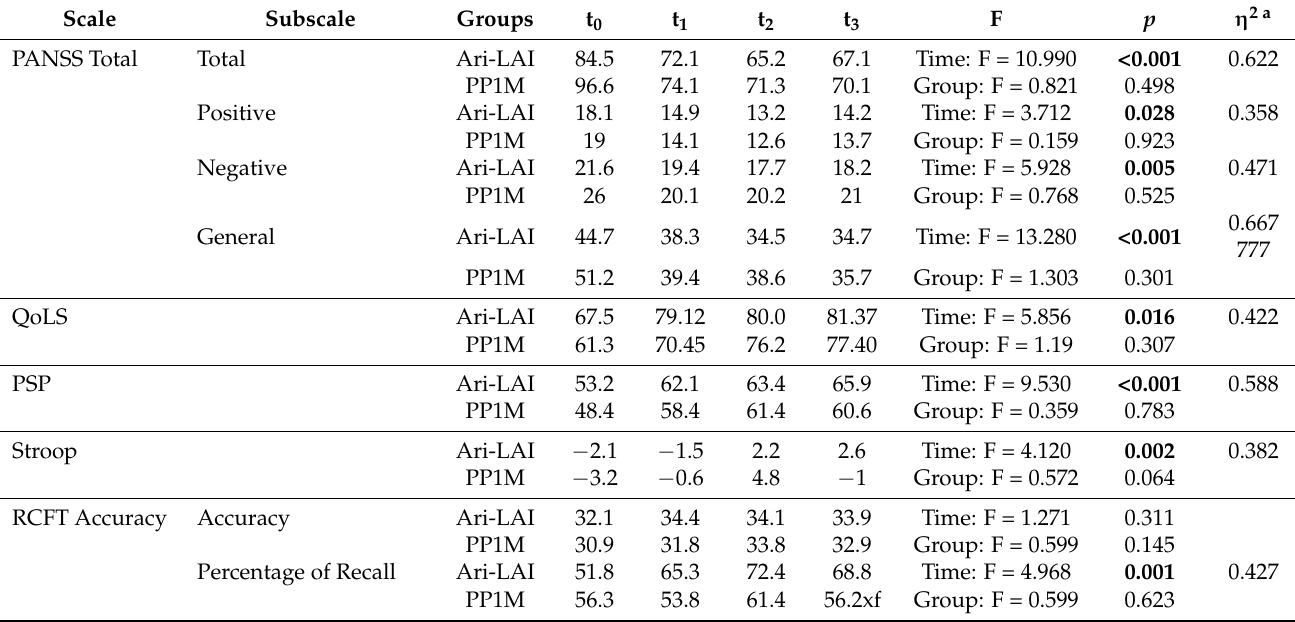
Table 2. General linear model repeated measures of the